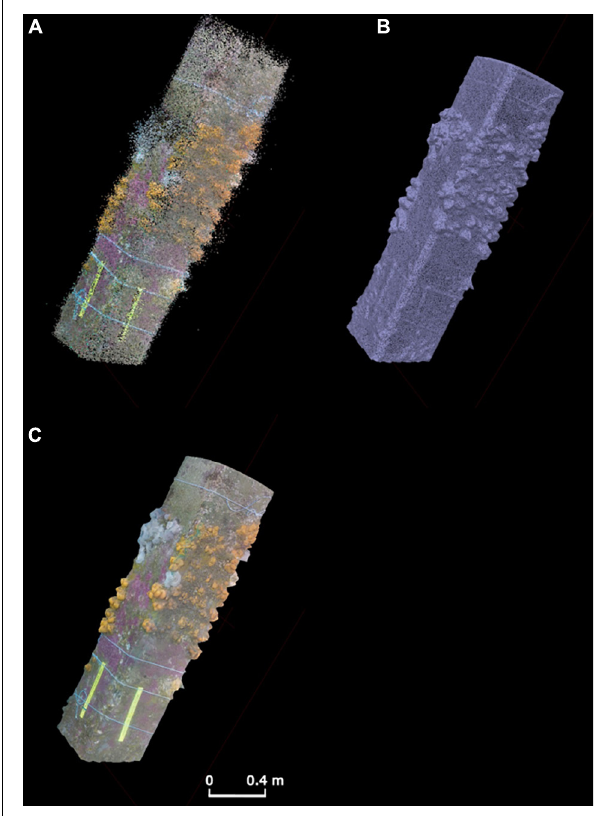
FIGURE 6 | The three stages of 3D model development underpinned by video/photographic imagery including (A) generation of point cloud (B) interpolation into mesh and (C) texturing with source images to produce a final model. Pictured here is a 2-m section of pier (pillar) with soft corals and